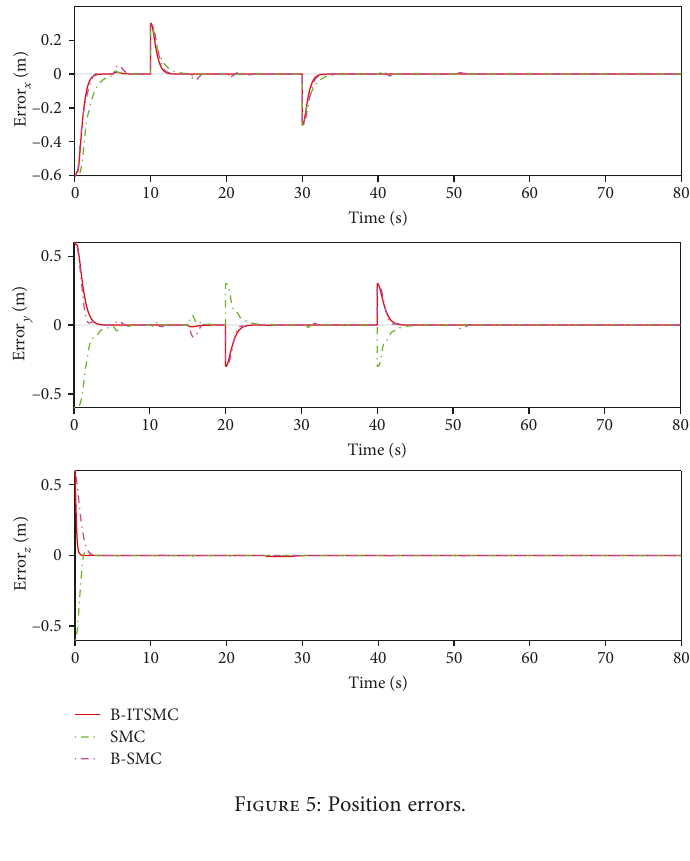
Figure 5: Position errors.